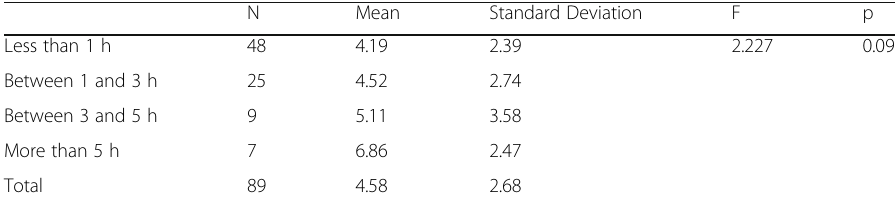
Table 5 ANOVA results for effect of daily average internet use to mental effort N Mean Standard Deviation F p Less than 1 h 48